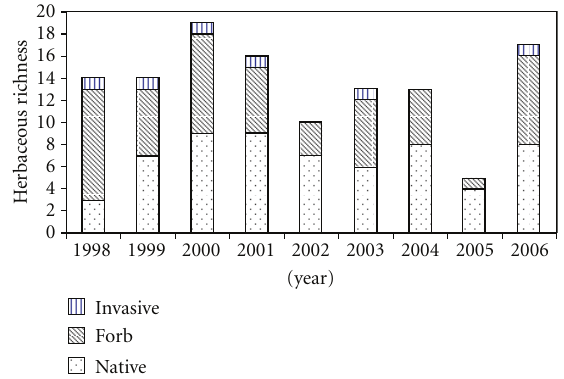
Figure 2: Mean species richness at disturbed sites (Xade) from 1998 to 2006. Native species refers to all indigenous species while invasive refers to Cenchrus